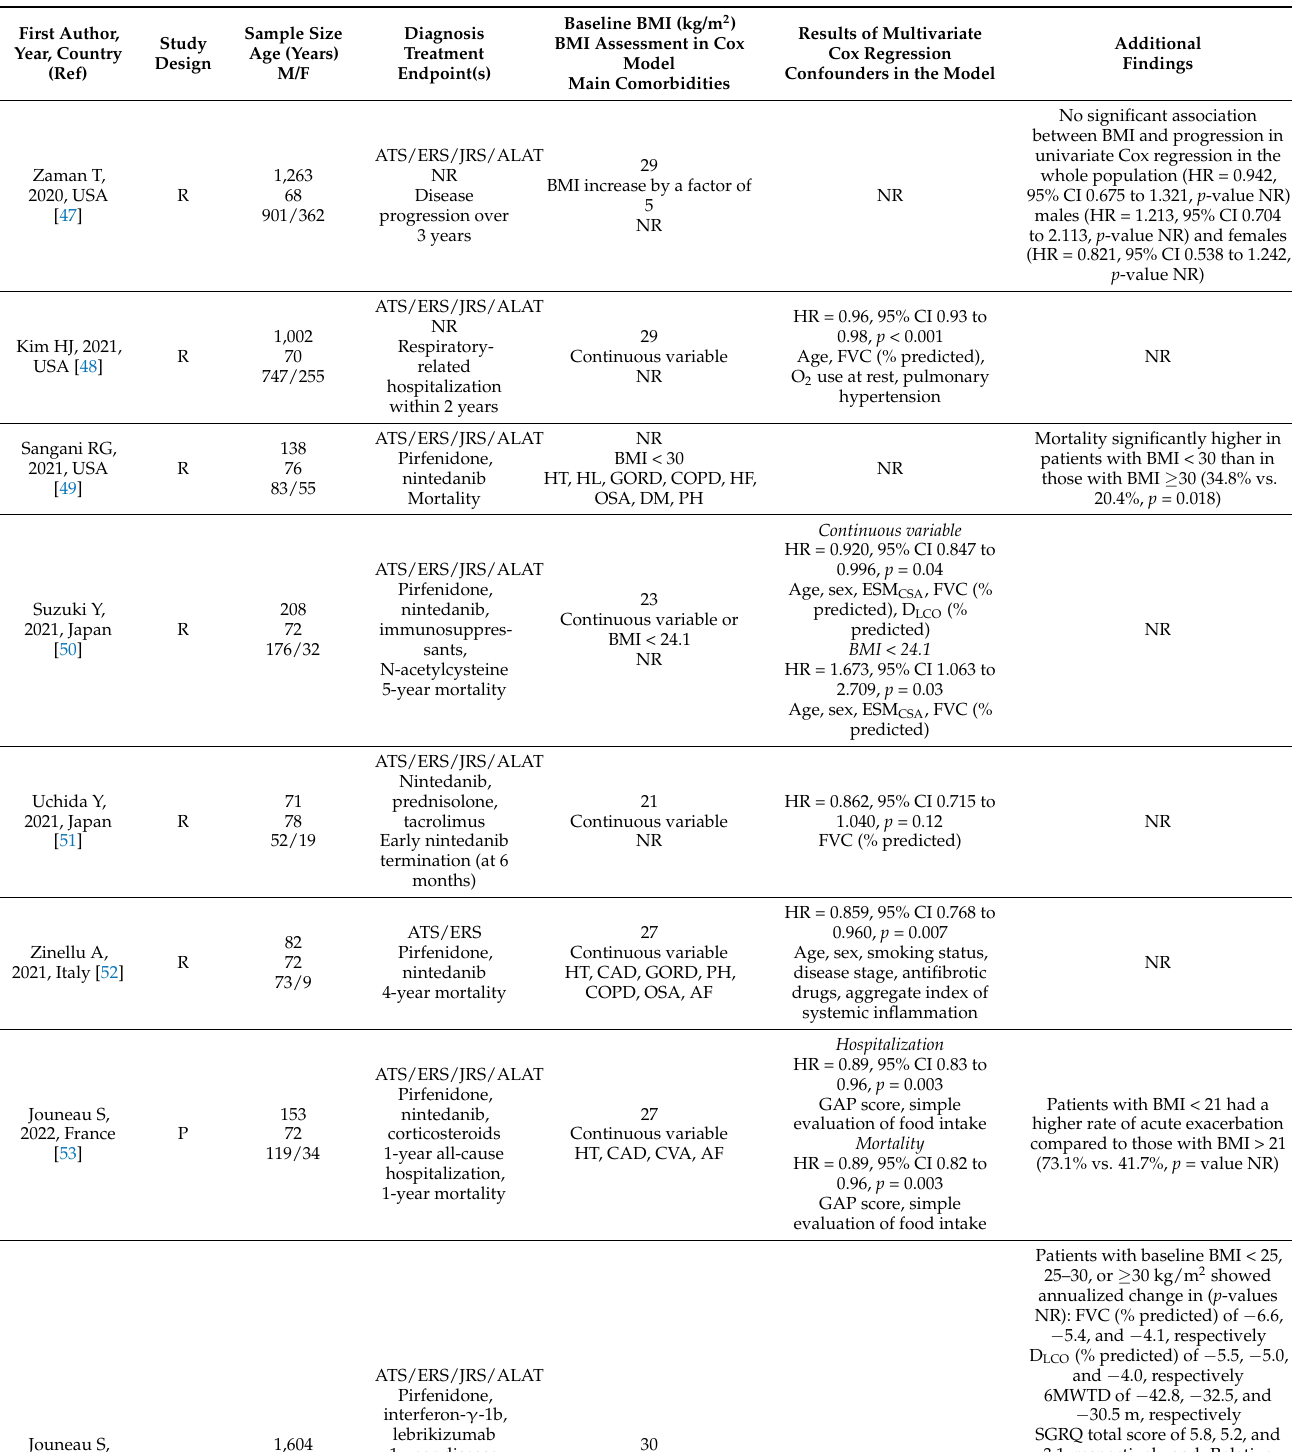
Patients with BMI < 21 had a higher rate of acute exacerbation compared to those with BMI > 21 (73.1% vs. 41.7%, p = value NR) GAP score, simple evaluation of food intake Patients with baseline BMI < 25, 25–30, or ≥ 30 kg/m 2 showed annualized change in ( p -values NR): FVC (% predicted) of − 6.6, − 5.4, and − 4.1, respectively D LCO (% predicted) of − 5.5, − 5.0, and − 4.0, respectively 6MWTD of − 42.8, − 32.5, and − 30.5 m, respectively SGRQ total score of 5.8, 5.2, and 3.1, respectively and: Relative decline in percent predicted FVC ≥ 10% or death in 19%, 15.1% and 9.4%, respectively Any all-cause hospitalization in 23.8%, 25.4%, and 24.5%, respectively All-cause mortality in 6.7%, 7.9%, and 6.2%, respectively Any treatment-emergent serious adverse effect in 26.7%, 30.6%, and 27.0%,